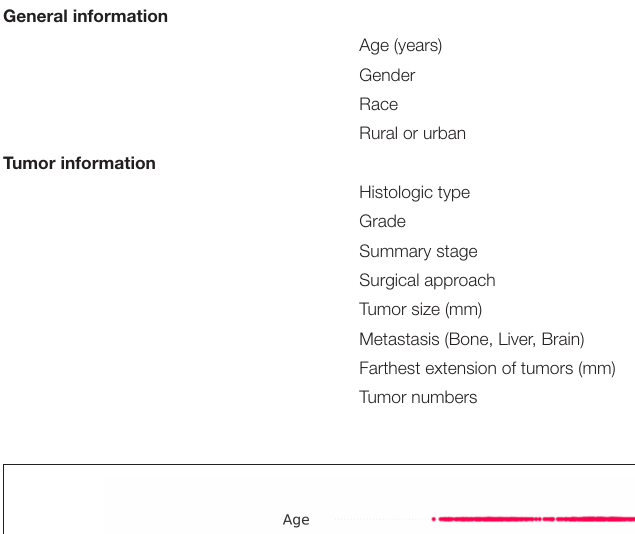
TABLE 3 | Features used in machine learning predictive models. General information